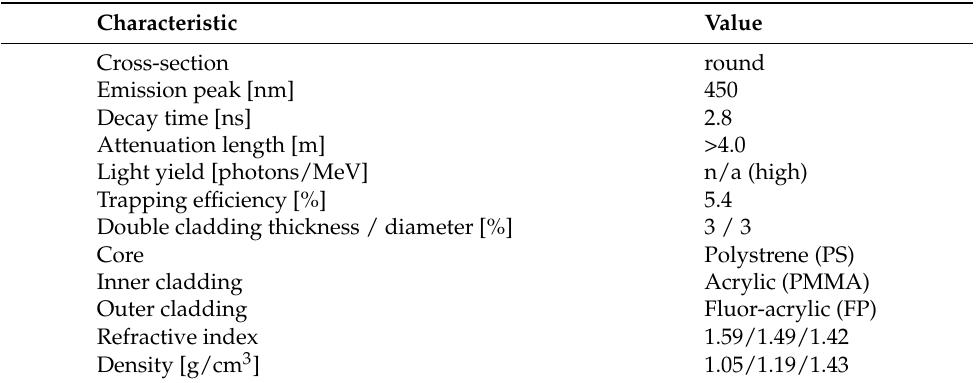
Table 3. Properties of the Kuraray SCSF-78MJ scintillating fibers as quoted by the manufacturer [1]. Characteristic Value Cross-section round Emission peak [nm] 450 Decay time [ns] 2.8 Attenuation length